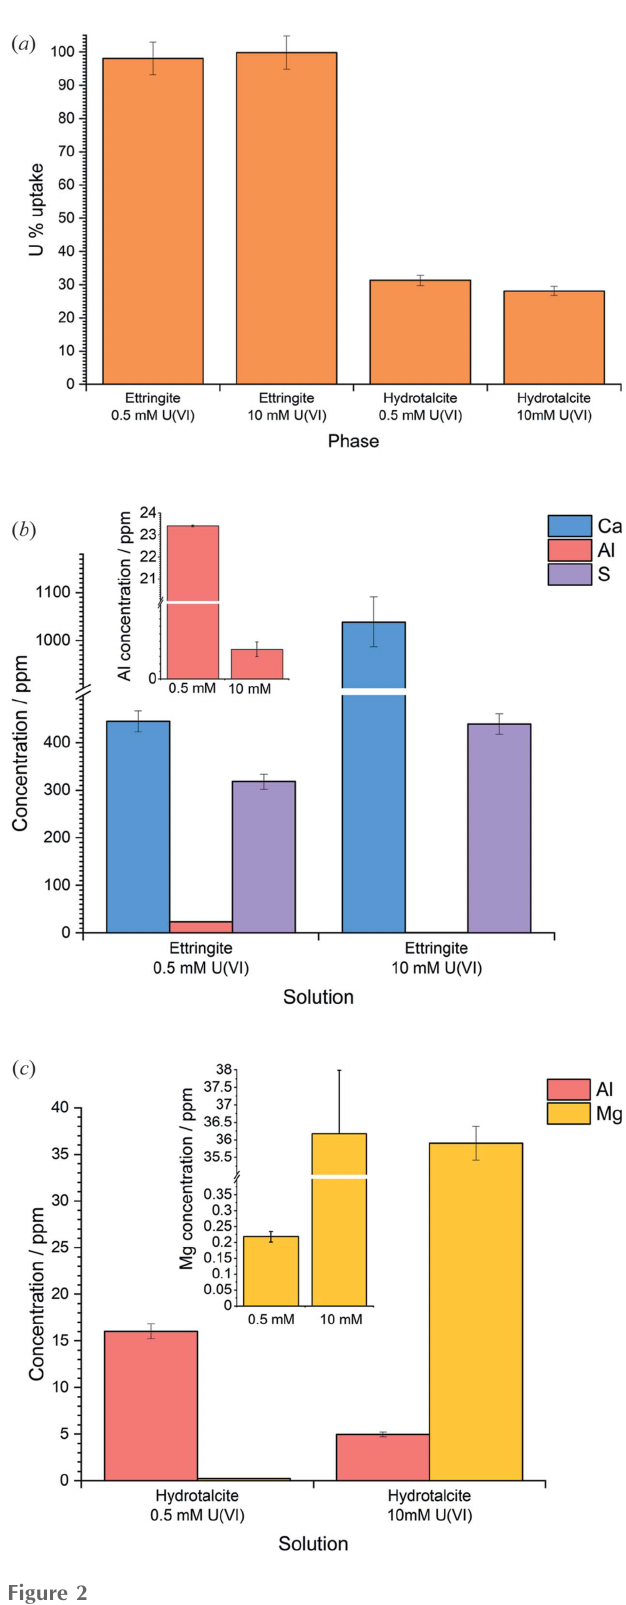
Figure 2 Aqueous elemental analysis of solutions containing U VI and cement minerals. ( a ) U VI removal from solution by ettringite and hydrotalcite as a percentage of [U VI ] t = 0 ; ( b ) Ca, Al and S release from ettringite in contact with U VI ; ( c ) Al and Mg release from hydrotalcite in contact with U VI . Error bars represent one standard deviation of triplicate samples.